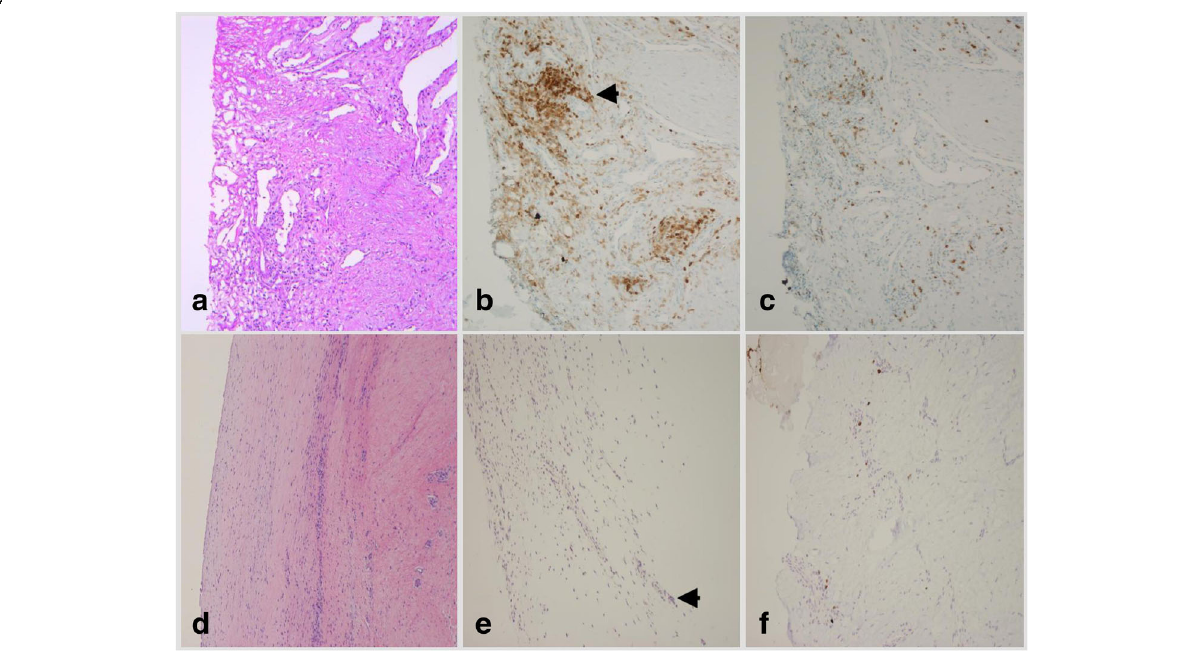
Fig. 1 ( a ) Chronic inflammatory nidus in a nickel-sensitive synovium after total knee arthroplasty (H&E × 40). Immunohistochemical staining for CD4 + T-cell ( b ) and CD8 + T cell ( c ) markers shows a relative predominance of CD4 + infiltrate, consistent with a delayed-type hypersensitivity (CD4 + immunohistochemistry X 40). ( d ) Synovial sample from a patient in the control group (H&E × 40). Immunohistochemical staining for CD4 + T cell ( e ) and CD8 + T cell ( f ) markers shows similar levels of inflammatory infiltrate (CD8 + immunohistochemistry ×40). Black arrowhead